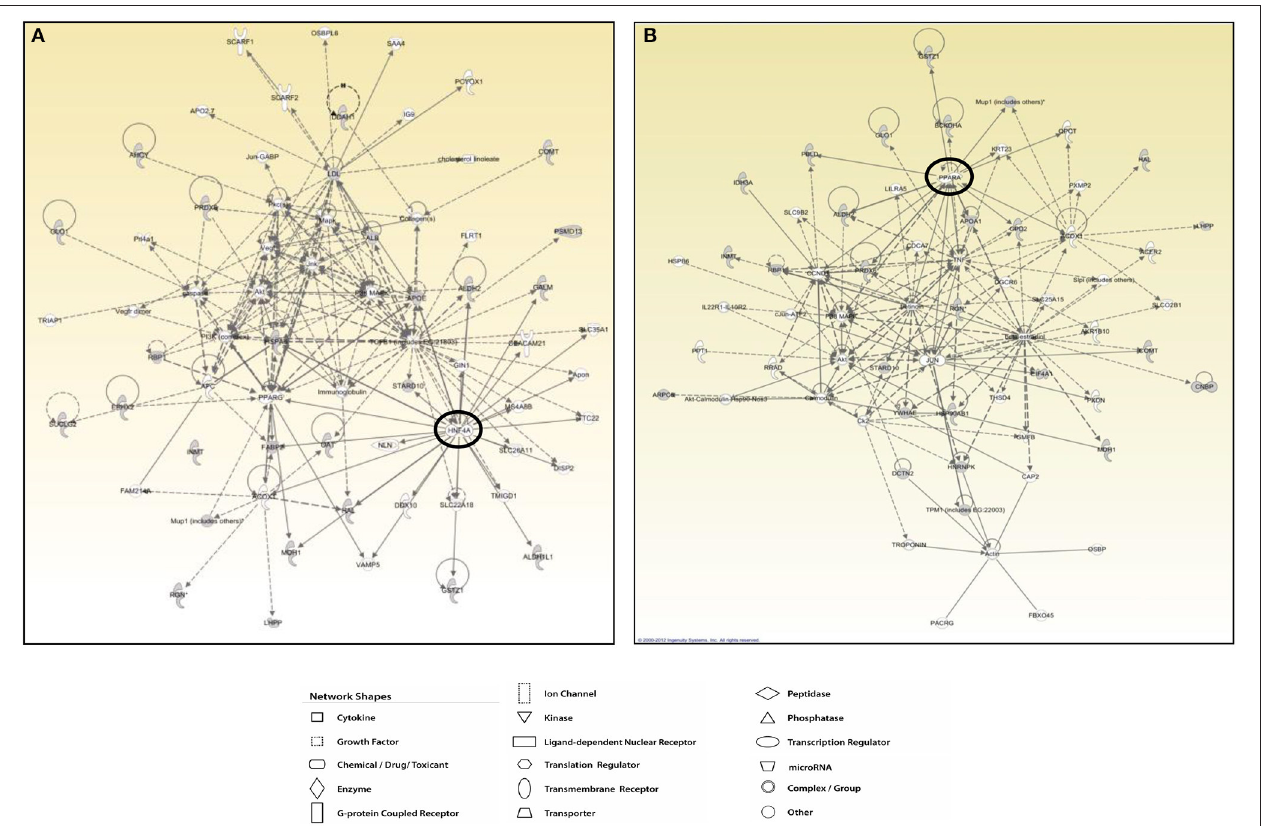
FIGURE 7 | T3 and T2 affected protein networks in liver of Ldlr − / − mice. Network representation of the molecular relationships between identified, differentially expressed proteins (Ingenuity Systems Ltd.) in liver of Ldlr − / − + T2 (A) and Ldlr − / − + T3 (B) vs. Ldlr − / − mice. Gene products are represented as nodes, and the biological relationship between two nodes is represented as an edge (line). Indirect interactions appear as broken lines, whereas direct interactions appear as solid lines. All edges shown are supported by at least 1 reference from the literature, from a textbook, or from canonical information stored in the Ingenuity Pathways Knowledge Base. Human, mouse, and rat orthologues of a gene are stored as separate objects in IPKB, but are represented as a single node in the network. For clarity, network shapes are